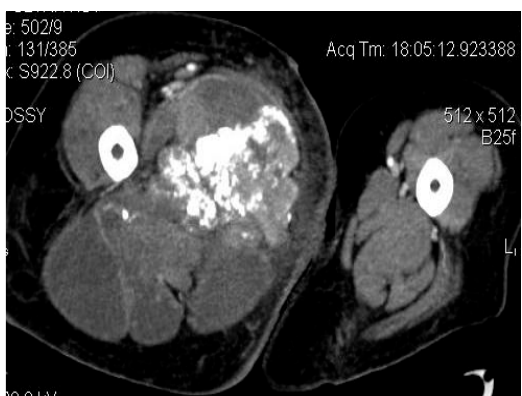
Figure 4. Axial CT-scan: evident enlargement of the right thigh; heterogeneous soft-tissue mass with calcifications, adjacent fat infiltration and skin thickening—synovial sarcoma, M, 26 YO patient.